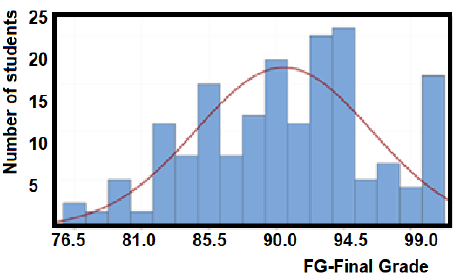
Figure 7. Statistics of the final grade (FG), which is added the contribution of the examination grade (CE), and the project grade (PG) for the EFR competency.